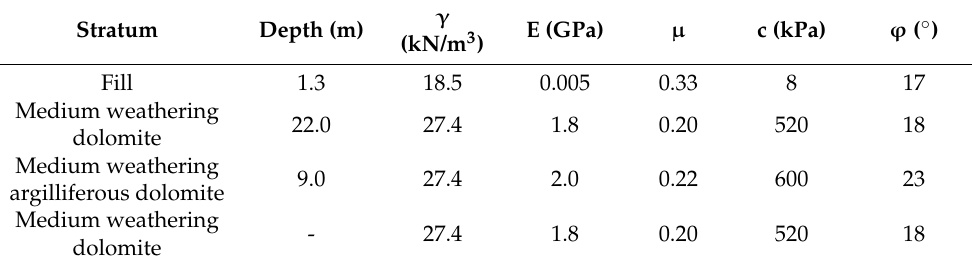
γ E (GPa) µ c (kPa) ϕ ( ◦ ) (kN/m 3 )